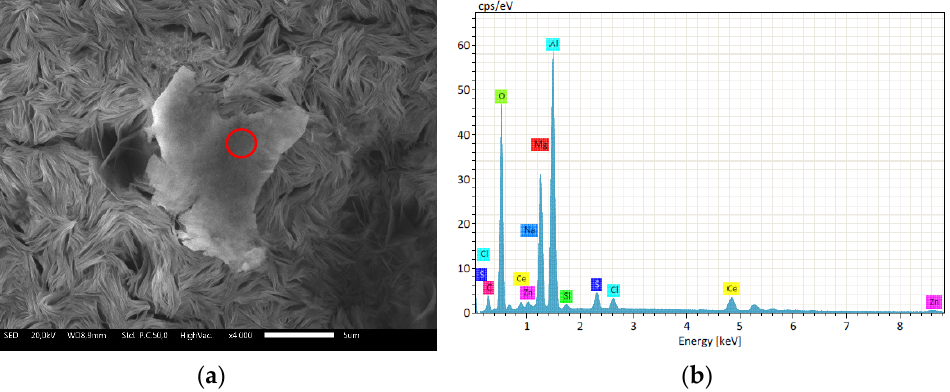
Figure 13. Ce-rich agglomerate on C10-1 surface after 226 h of immersion ( a ) and EDS analysis in correspondence of the red spot ( b ).